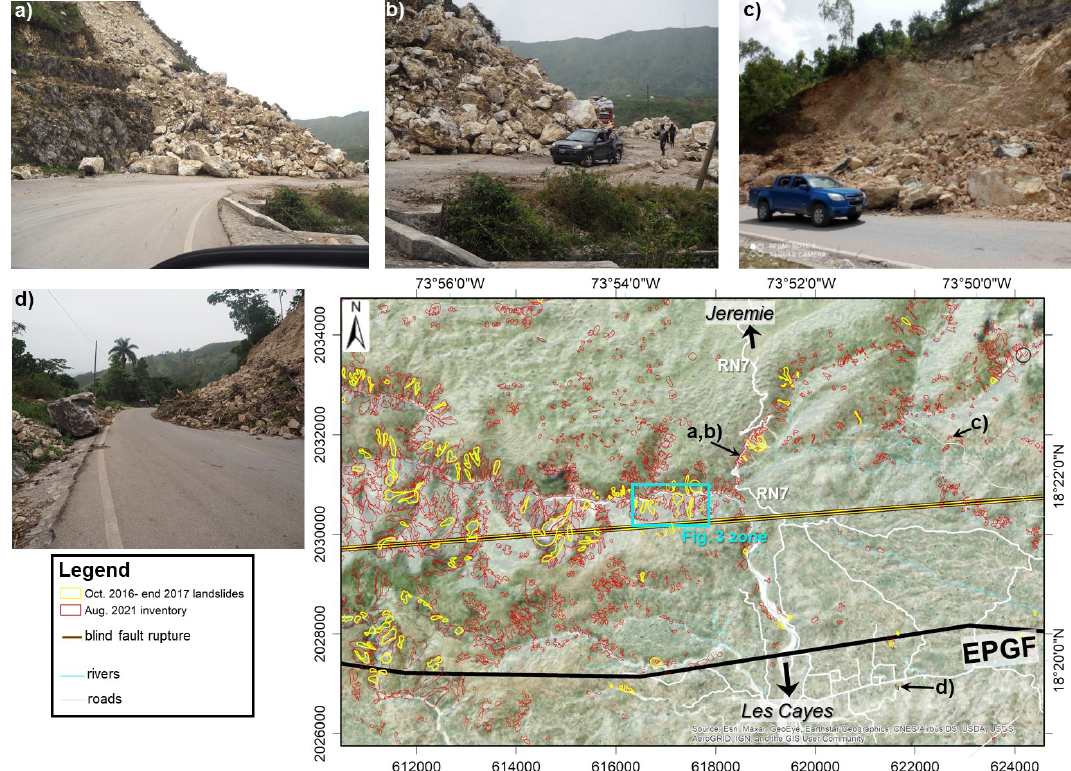
Figure 2. Examples of landslides photographed in the field, especially along the national road RN7, connecting the two provincial cities of Les Cayes in the south and Jeremy in the north. The map (semi-transparent hillshade on high-resolution satellite imagery, © ESRI) also shows the different ground failure effects mapped before (yellow polygons) and after the earthquake (dark-red polygons). See blue rectangle marking the outline of the view extent shown in Fig. 3 (and in Fig. A2).